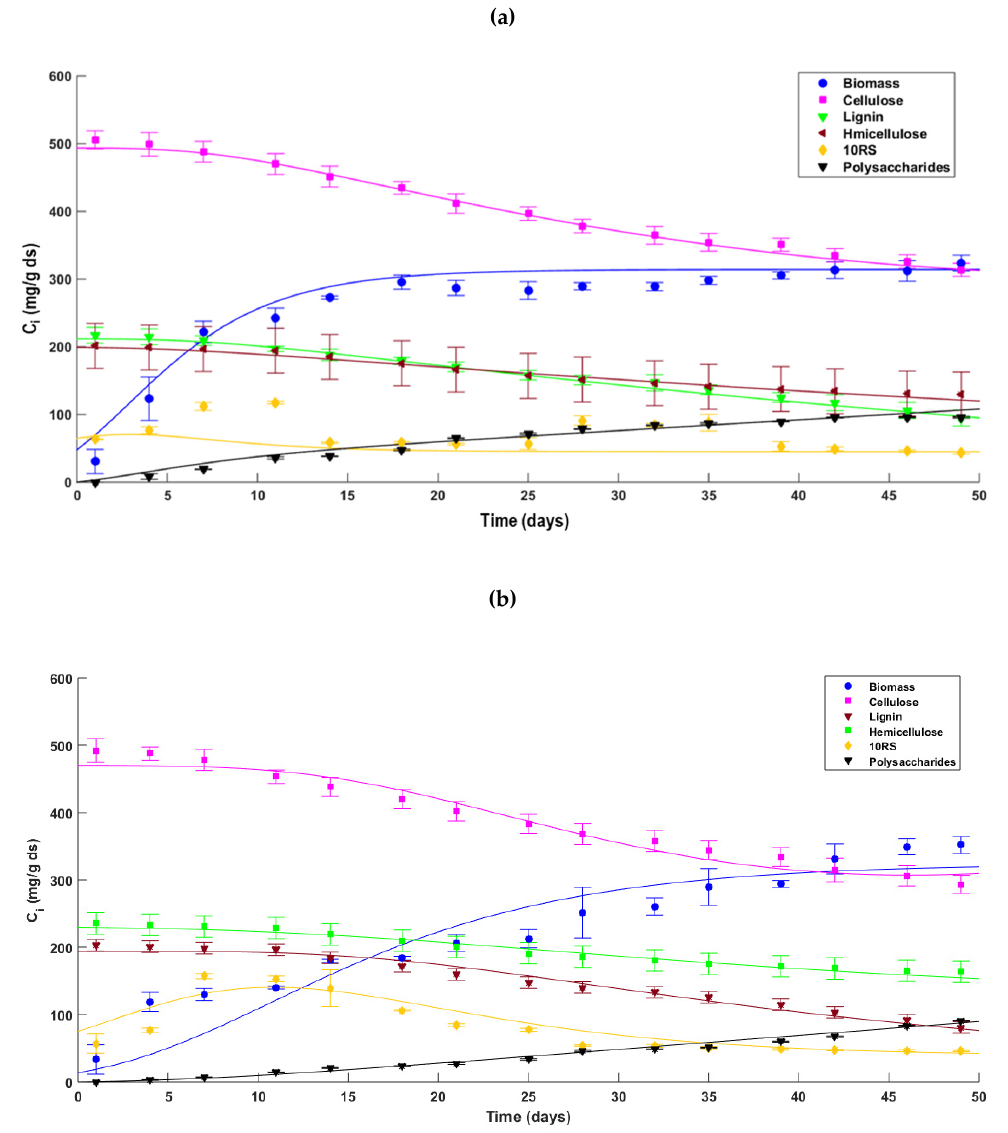
Figure 4. Time profile of cell biomass, polysaccharide production, and cellulose, hemicellulose, and lignin degradation by T. versicolor grown on di ff erent solid media. ( a ) Kinetic behavior for F2 medium. ( b ) Kinetic behavior for F4 medium. The continuous lines were calculated by the model proposed. The values for reducing sugars are multiplied by 10; C i : concentration, ds: dry solid, RS: reducing sugars.